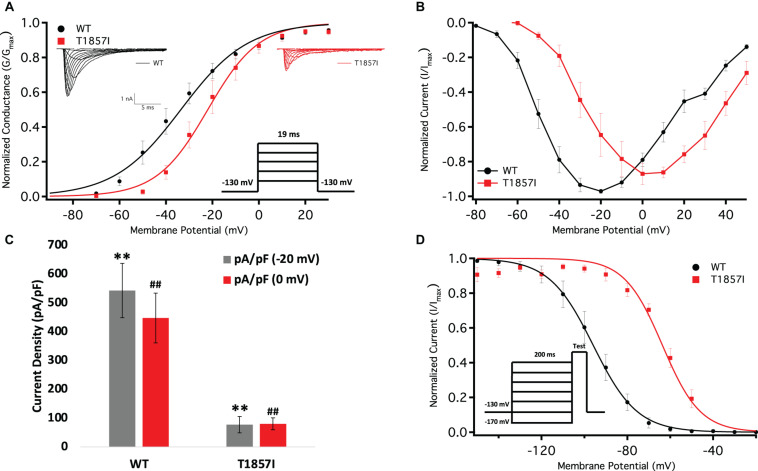
Comparison of the Voltage-Dependence of Activation/Fast Inactivation Between WT and T1857I. (A) Voltage-dependence of activation as normalized conductance plotted against membrane potential. Sample macroscopic sodium currents elicited by depolarizations between −100 and +80 mV (reversal potential: WT = 49.7 ± 4 mV, TI = 59.5 ± 2 mV). (B) Normalized current and voltage relationship. Each recording was normalized relative to its own maximal peak value. The normalized current and voltage relationships shown are averaged for each condition. (C) Average current (Y-axis) density of WT and T1857I. (D) Voltage-dependence of steady-state fast inactivation as normalized current plotted against membrane potential. ** and ## represent statistical significance.